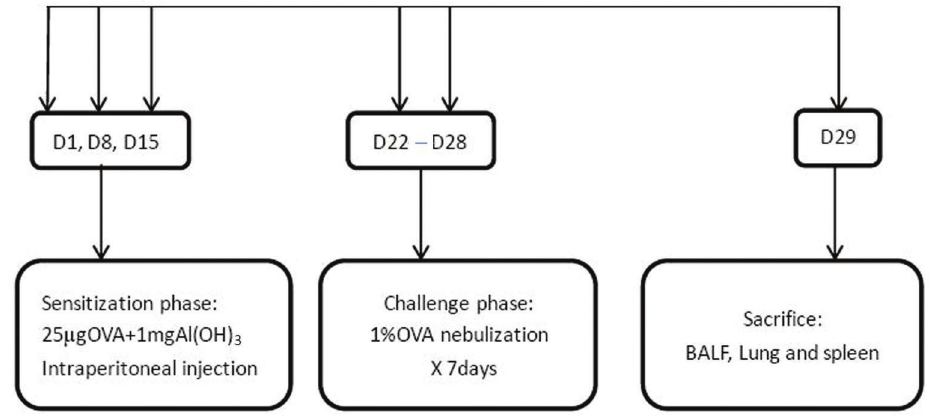
Figure 1. Flow chart of the ovalbumin (OVA) sensitization model of asthmatic BALB/c mice. The mice were randomly divided into 2 groups and treated as shown above. D: